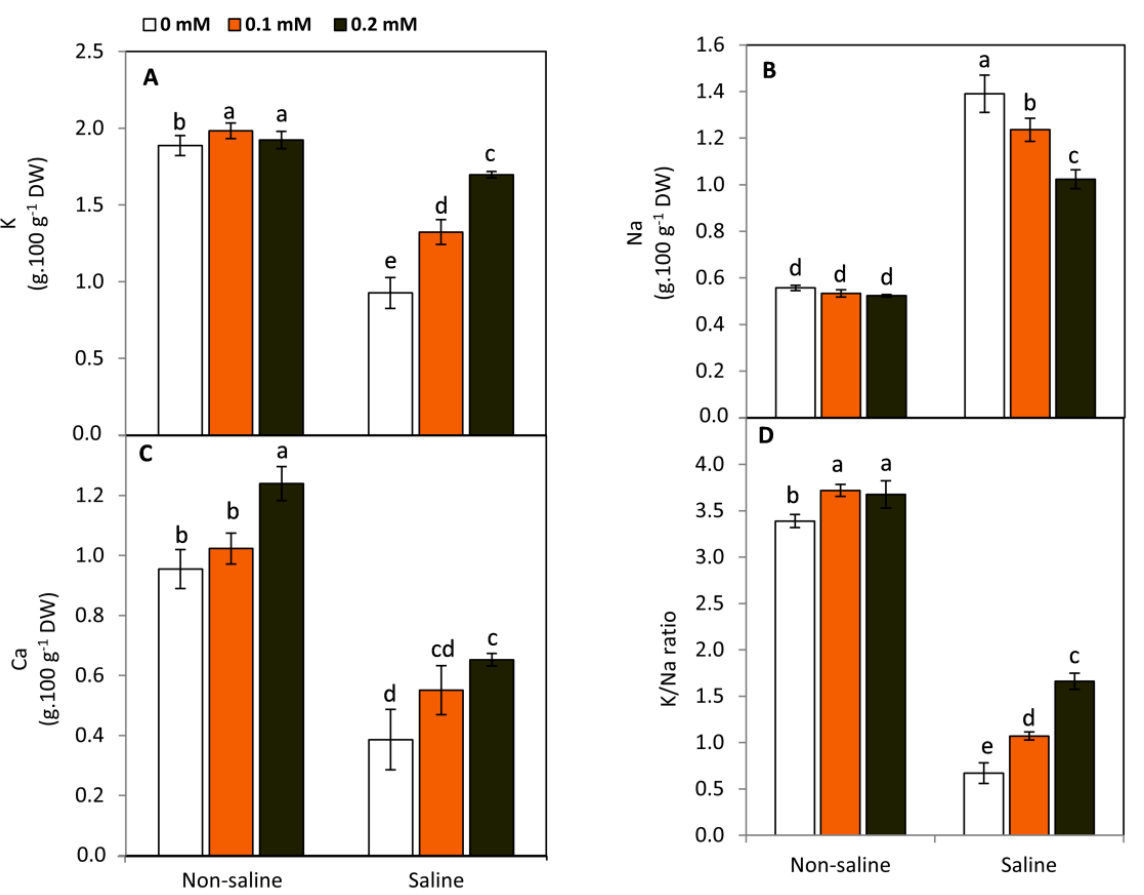
Figure 6. Effect of exogenous folic acid (FA; 0, 0.1, and 0.2 mM) on K ( A ), Na ( B ), Ca ( C ), and K/Na ratio ( D ) in the leaves of snap bean plants grown under non-stressed and saline-stressed (50 mM, NaCl) conditions. Bars represent standard deviation (SD) of the means (n = 3). Values are the averages of three replicates ± SD. Different letters indicate significant differences according to Duncan’s multiple range tests ( p < 0.05).